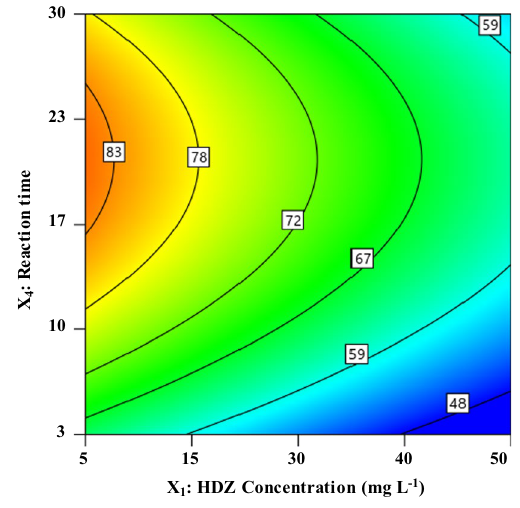
Fig. 3 Contour plot of the reaction time and initial HDZ concentra- tion on the HDZ removal efficiency